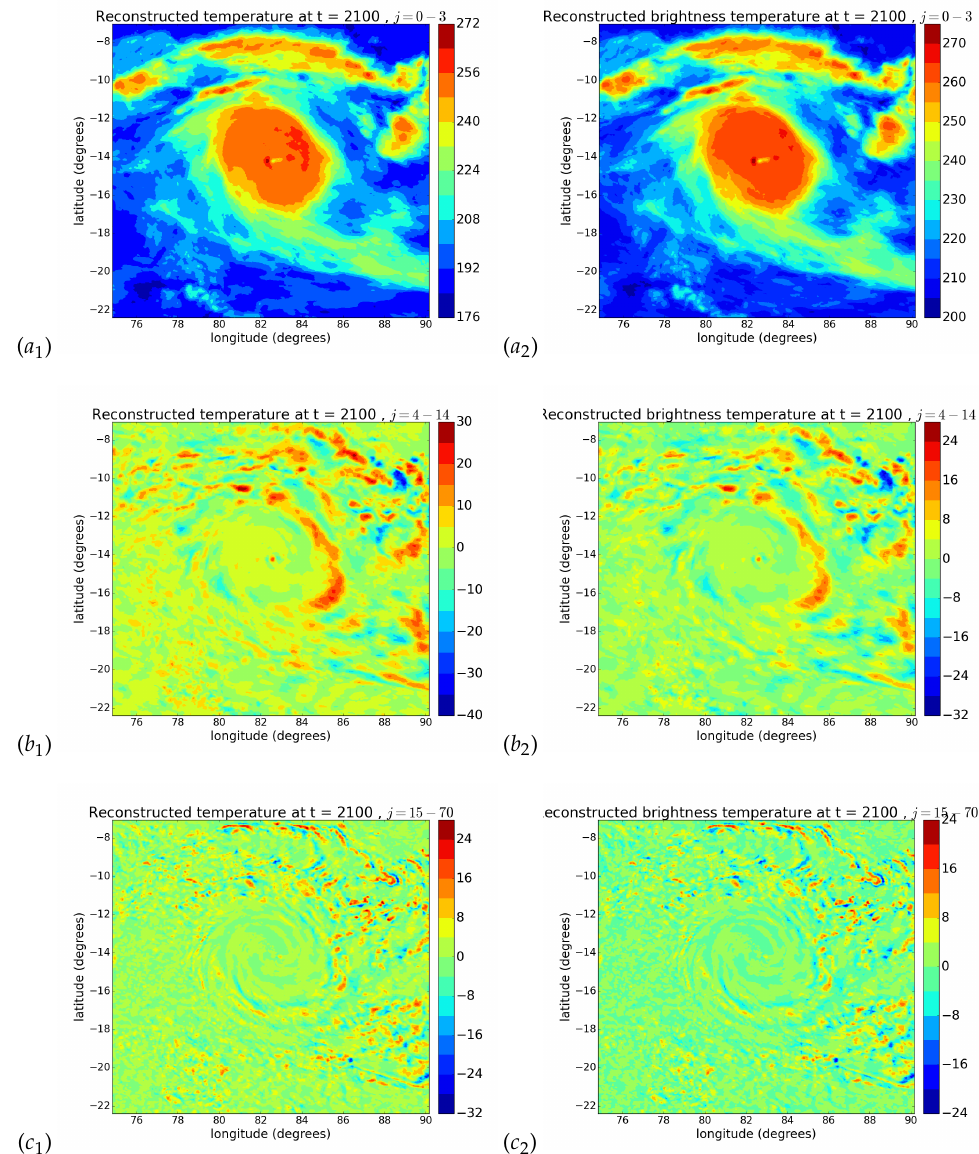
Figure 10. Comparison between effective temperature field reconstructions (suffix 1) and brightness temperature ones (suffix 2), at 21.00 UTC on 8 February 2021 for Faraji hurricane. We show large scales in ( a ), intermediate scales in ( b ) and small scales in ( c